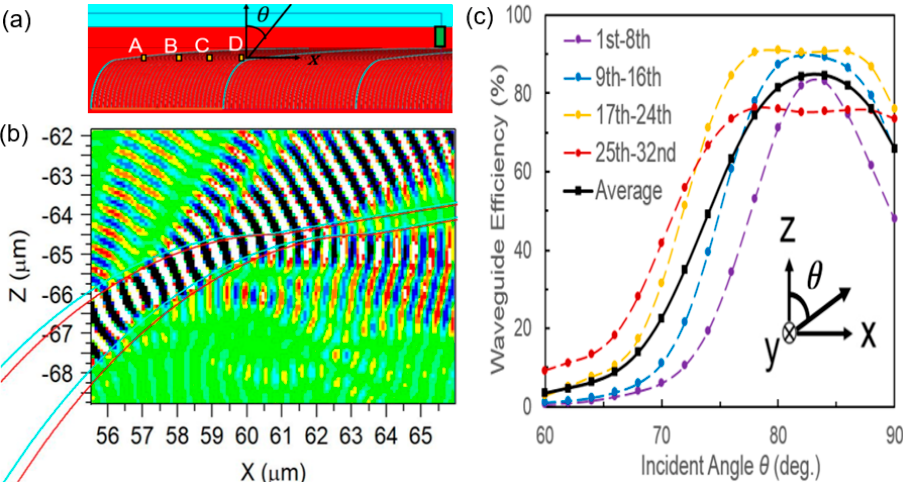
Figure 8. ( a ) Light injection at locations A, B, C, and D in the upper partial ellipses, ( b ) simulation of the optical field at around the connection region of the vertical-lower and the horizontal-upper partial ellipses, and ( c ) incident angle θ dependence of the efficiency of the light injection into the 2D waveguide at locations A, B, C, and D in the upper partial ellipses (for λ = 1000 nm).